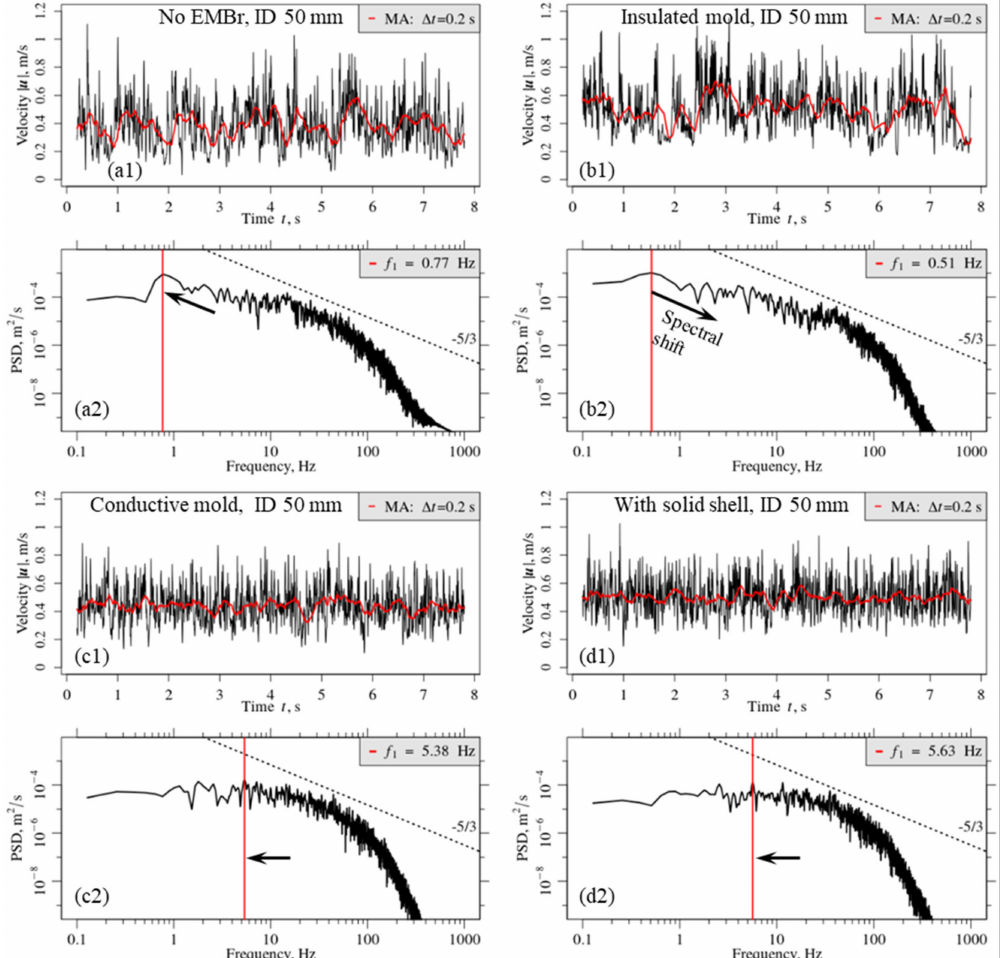
Figure 18. Instantaneous velocity at the monitor point P1 with moving average (top subfigures) and corresponding PSD (bottom subfigures), immersion depth (ID) of 50 mm: ( a1 , a2 ) Case 0B; ( b1 , b2 ) Case 1B; ( c1 , c2 ) Case 2B; ( d1 , d2 ) Case